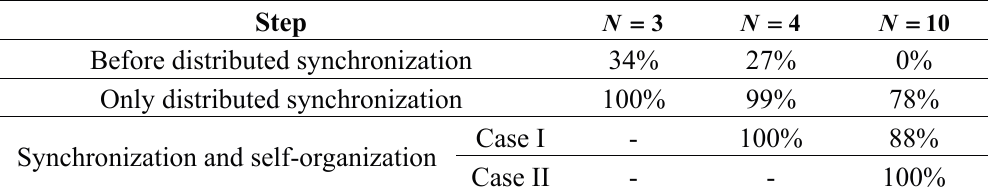
Table 2. Synchronization success probability of the proposed technique.